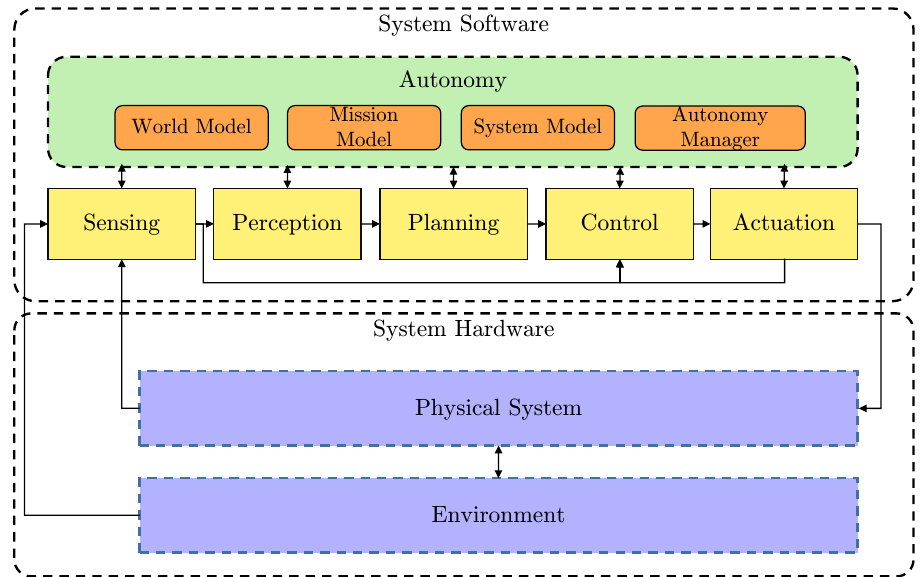
Figure 1. Simplified high-level system